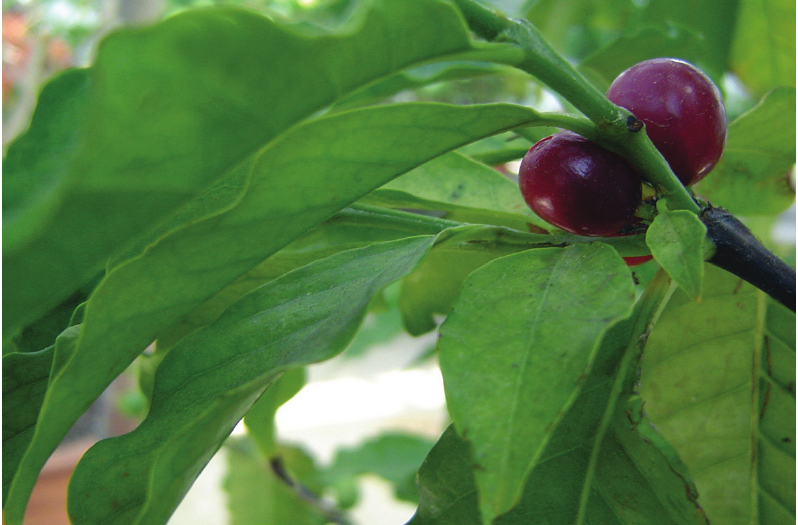
Figure 13. Coffea arabica L.: leaves and fruits (coffee